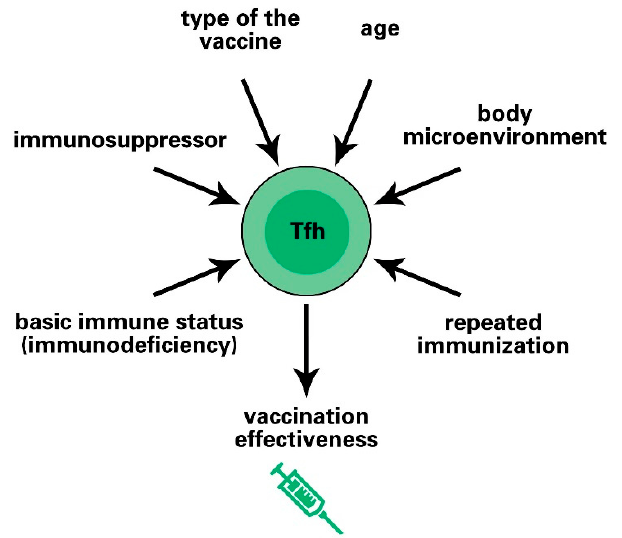
Figure 2. Simplified illustration of the factors that affect vaccine effectiveness by modulating Tfh cell response. Vaccine effectiveness is dependent on the activation levels of Tfh cells. Tfh cell responses can be altered by various factors, including the type of vaccine, age, body microenvironment, repeated immunization, basic immune status, and immunosuppressors.